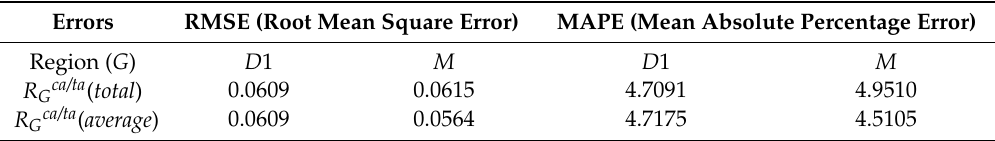
Table 3. Root mean square errors (RMSEs) and mean absolute percentage errors (MAPEs) between e-BMD G ( type ) and BMD f